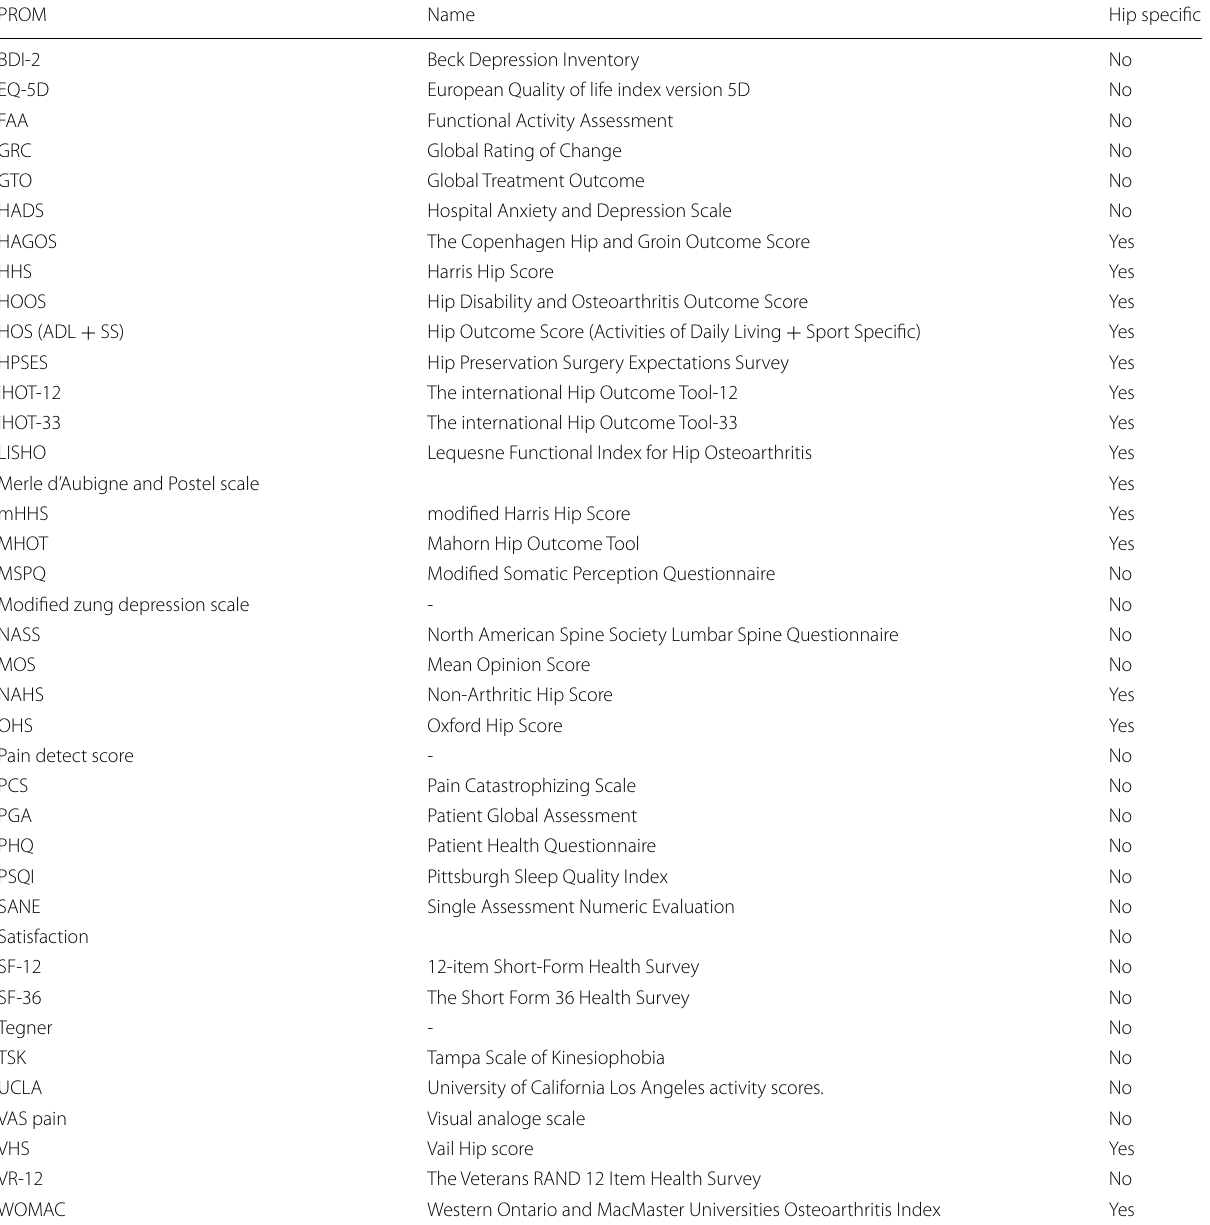
Table 3 Included patient-reported outcome measures (PROMs) and their